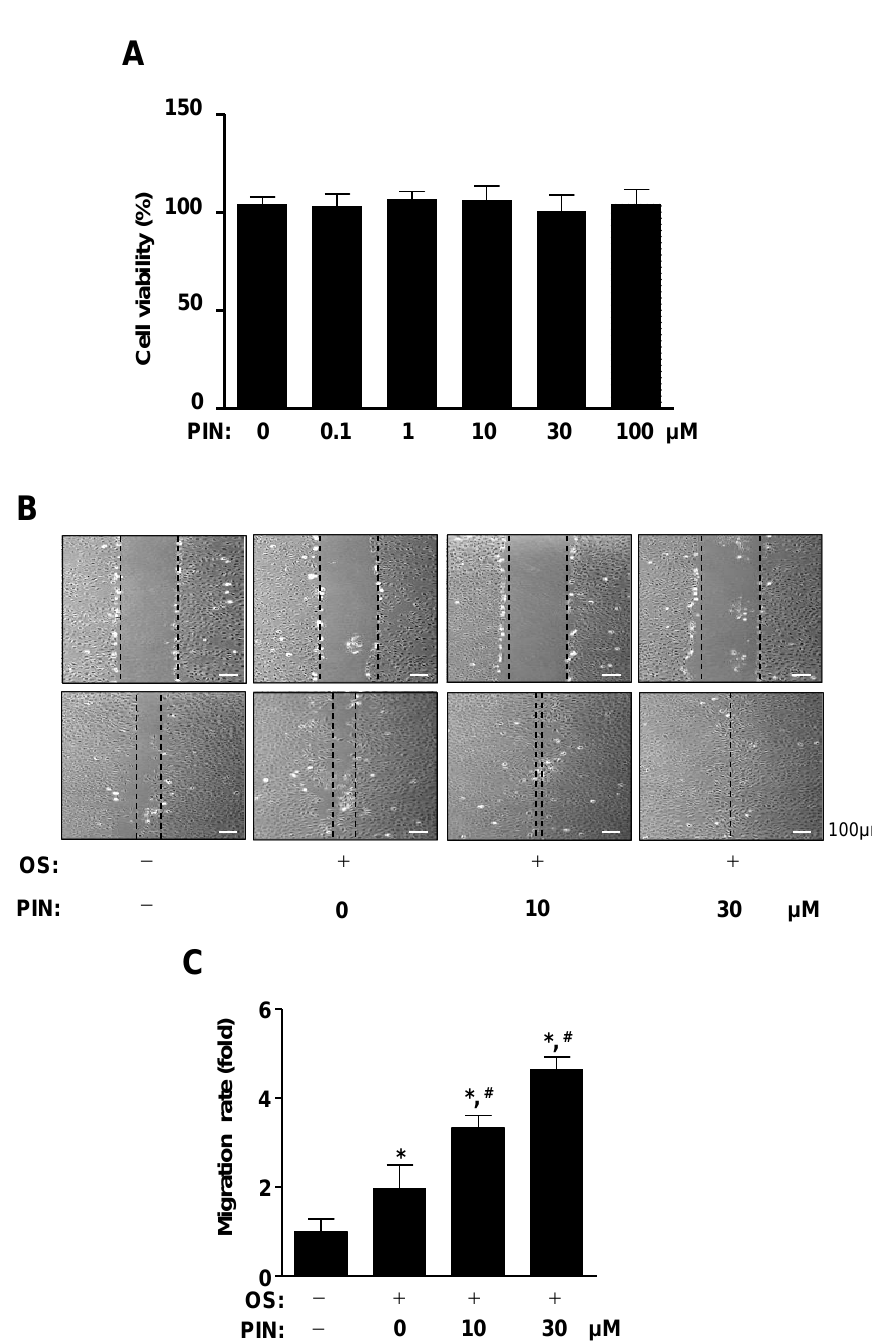
Figure 2. E ff ect of PIN on cytotoxicity in pre-osteoblasts and cell migration during osteoblast di ff erentiation. ( A ) Pre-osteoblasts were cultured in 0.1, 1, 10, 30, and 100 µ M of PIN f cell migration during osteoblast di ff erentiation or 24 h. Cytotoxicity was assessed using an 3-[4,5-dimethylthiazol-2-yl]-2,5-diphenyltetrazolium bromide (MTT) assay and measured at a wavelength of 540 nm using a spectrophotometer. ( B , C ) After pre-osteoblasts were cultured in osteogenic supplement medium (OS) containing 50 µ g / mL L-ascorbic acid (L-AA) and 10 mM β -glycerophosphate ( β -GP) with 10 and 30 µ M PIN for 24 h, cell migration was observed under a light microscope ( B ), and cell migration rate (fold) was measured and exhibited as a bar graph ( C ). Data represent the mean ± S.E.M. of experiments. *, p < 0.05 indicates statistically significant di ff erence, compared with the control. #, p < 0.05 indicates statistically significant di ff erence when compared with